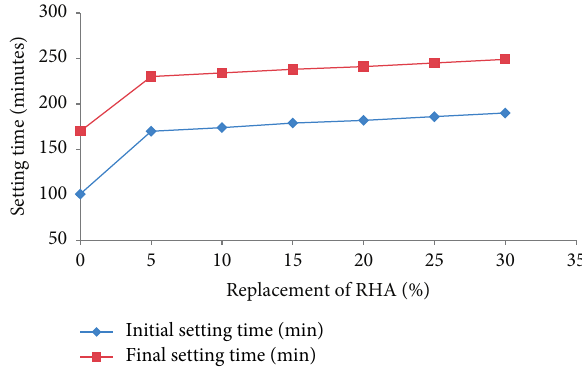
Figure 4: Setting time of RHA-blended cements at different re- placements of